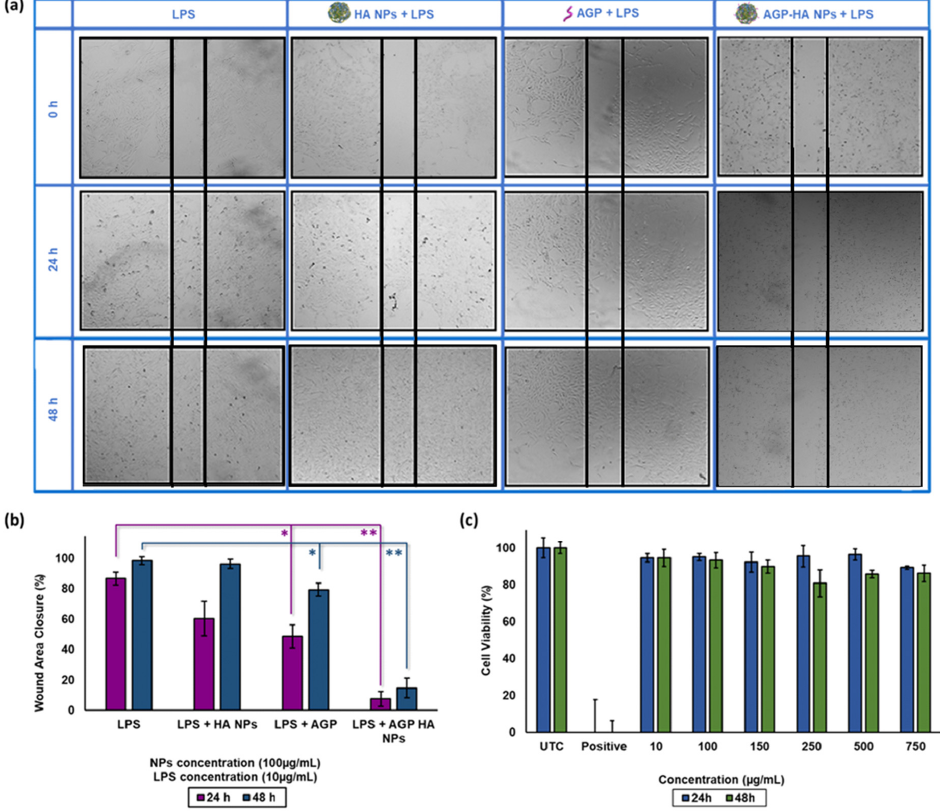
Figure 3. ( a , b ) Scratch assay of hyaluronic acid nanoparticles (HA NPs), α 1 -acid glycoprotein (AGP), α 1 -acid glycoprotein-conjugated hyaluronic acid nanoparticles (AGP-HA NPs) at 24 and 48 h incubation time mediates with LPS in MCF-7 cells. ( c ) Cytotoxicity of hyaluronic acid nanoparticles (HA NPs) at 24 h and 48 h incubation time using AlamarBlue assay in MCF-7 cells. All data presented in averages and standard deviations from at least three independent experiments. Statistical analysis was determined using Student’s t -test ( ** p < 0.01, * p <